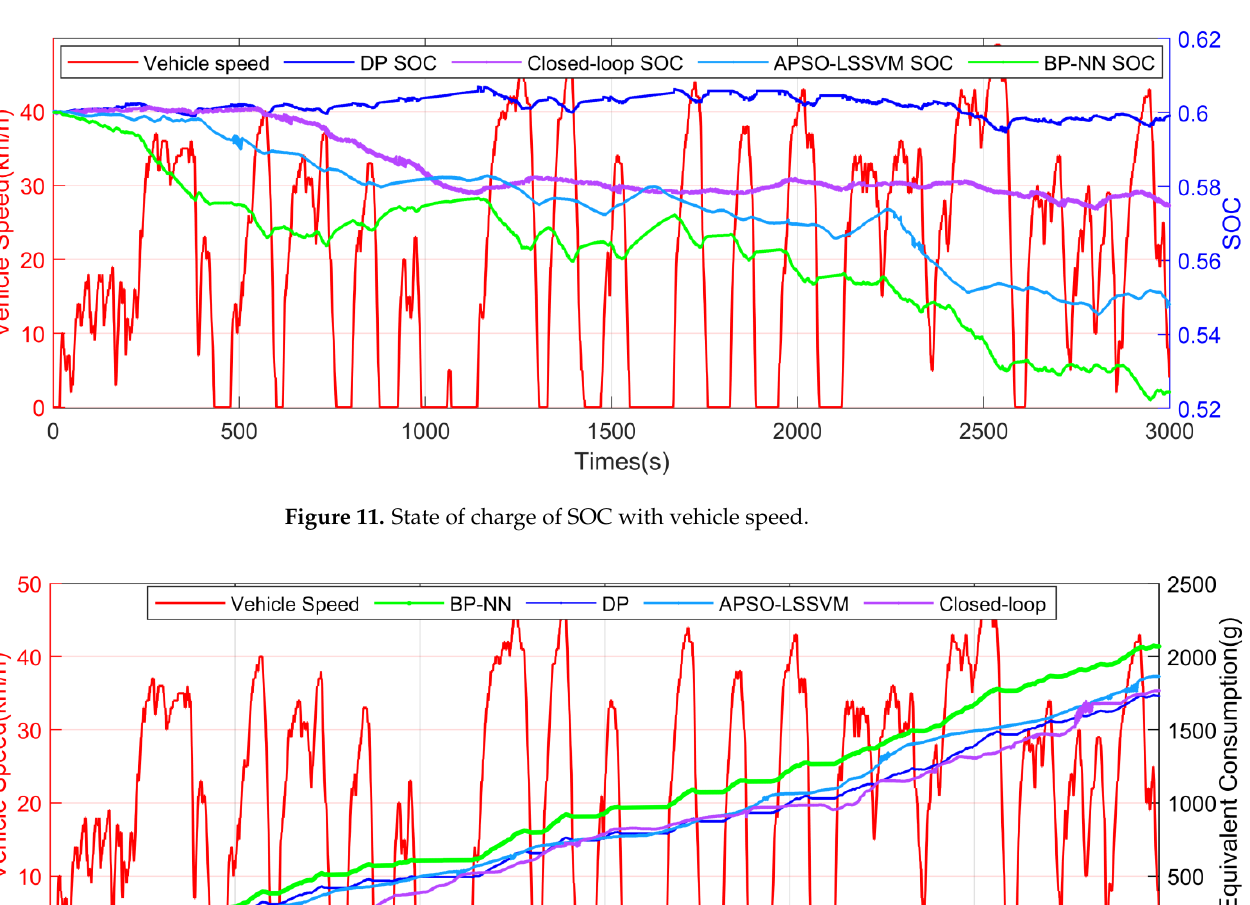
Figure 10. Driving speed and driving distance.